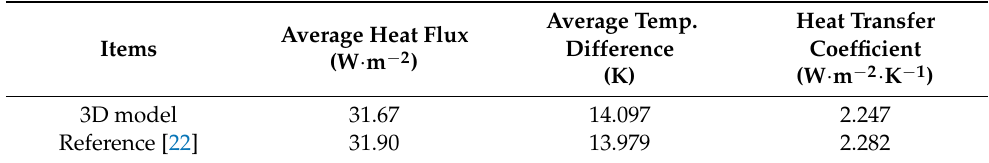
Figure 4. ( a ) Right calculation path in the 3D model; ( b ) heat flux (W·m − 2 ) of each node in the right path.